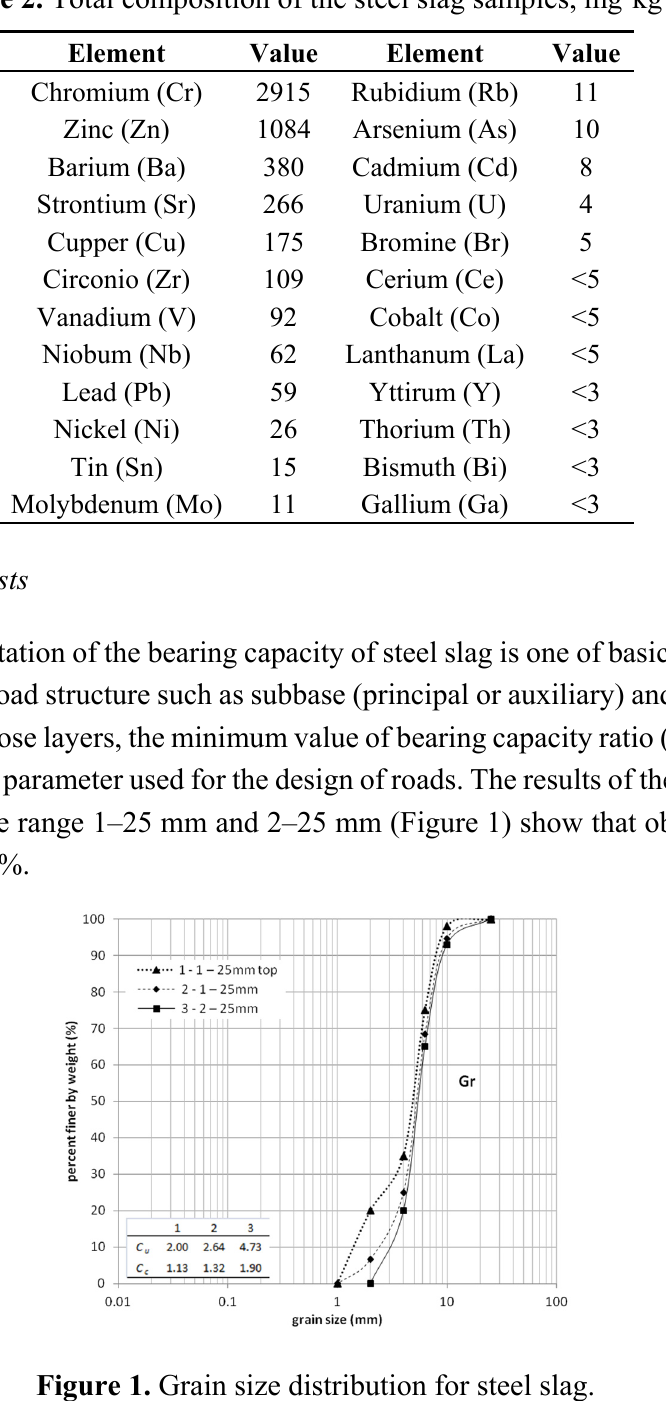
Table 2. Total composition of the steel slag samples, mg·kg − 1 .